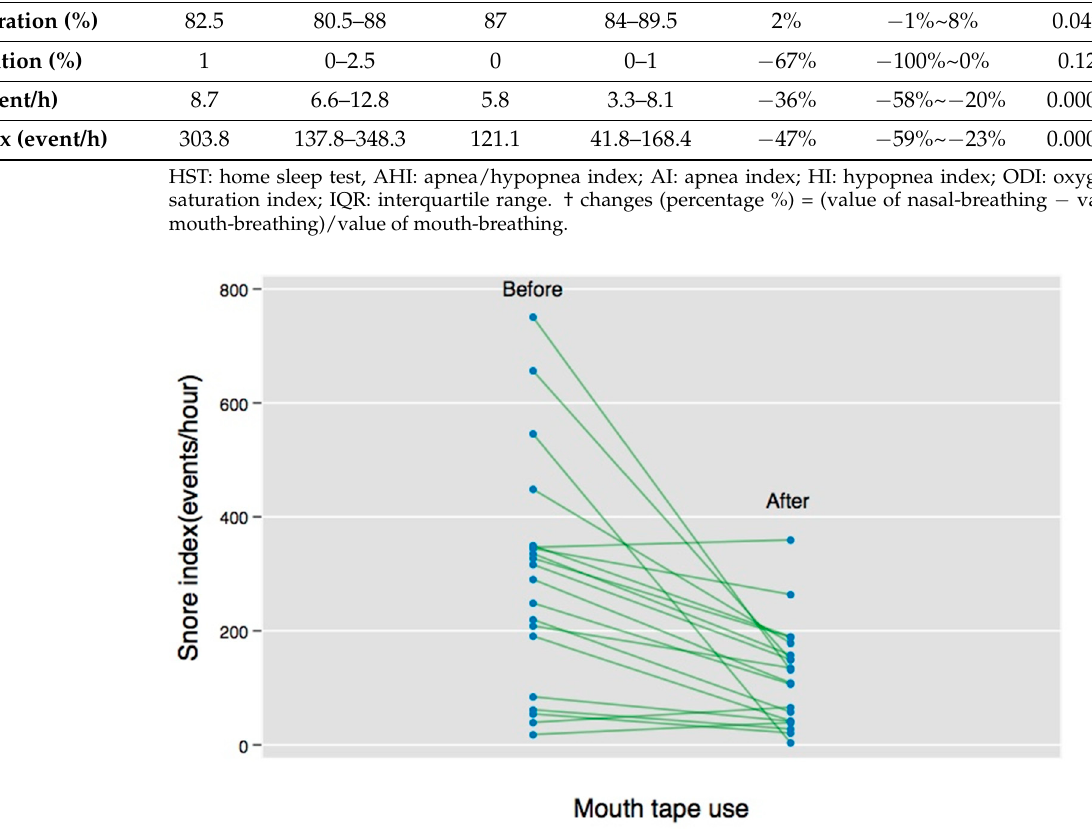
Figure 3. Individual change in snoring index (SI) before and after mouth-taping. An association between the use of mouth tape and a change in the mean saturation and 90% saturation during sleep was not found in the study. However, significant improvements in ODI ( p value = 0.0003) and SI ( p value = 0.0002) were shown, from 8.7 to 5.8 and 303.8 to 121.1, respectively. No significant factors (including age, sex, BMI, and all sleep parameters) affecting response (>50% reduction from baseline snoring index) of the use of mouth tape were found in the analysis. The correlations between variables contributing to the change in the AHI and SI were also examined. A statistically significant correlation of change in AHI was seen in the baseline AHI (r = − 0.52, p value =0.02), the baseline oxygen desaturation index (ODI) (r = − 0.54, p value =0.01), and the baseline SI ( ρ = − 0.47, p value = 0.04). Furthermore, a change in SI was associated with a baseline SI (r = − 0.77, p value =0.001) (see Figure